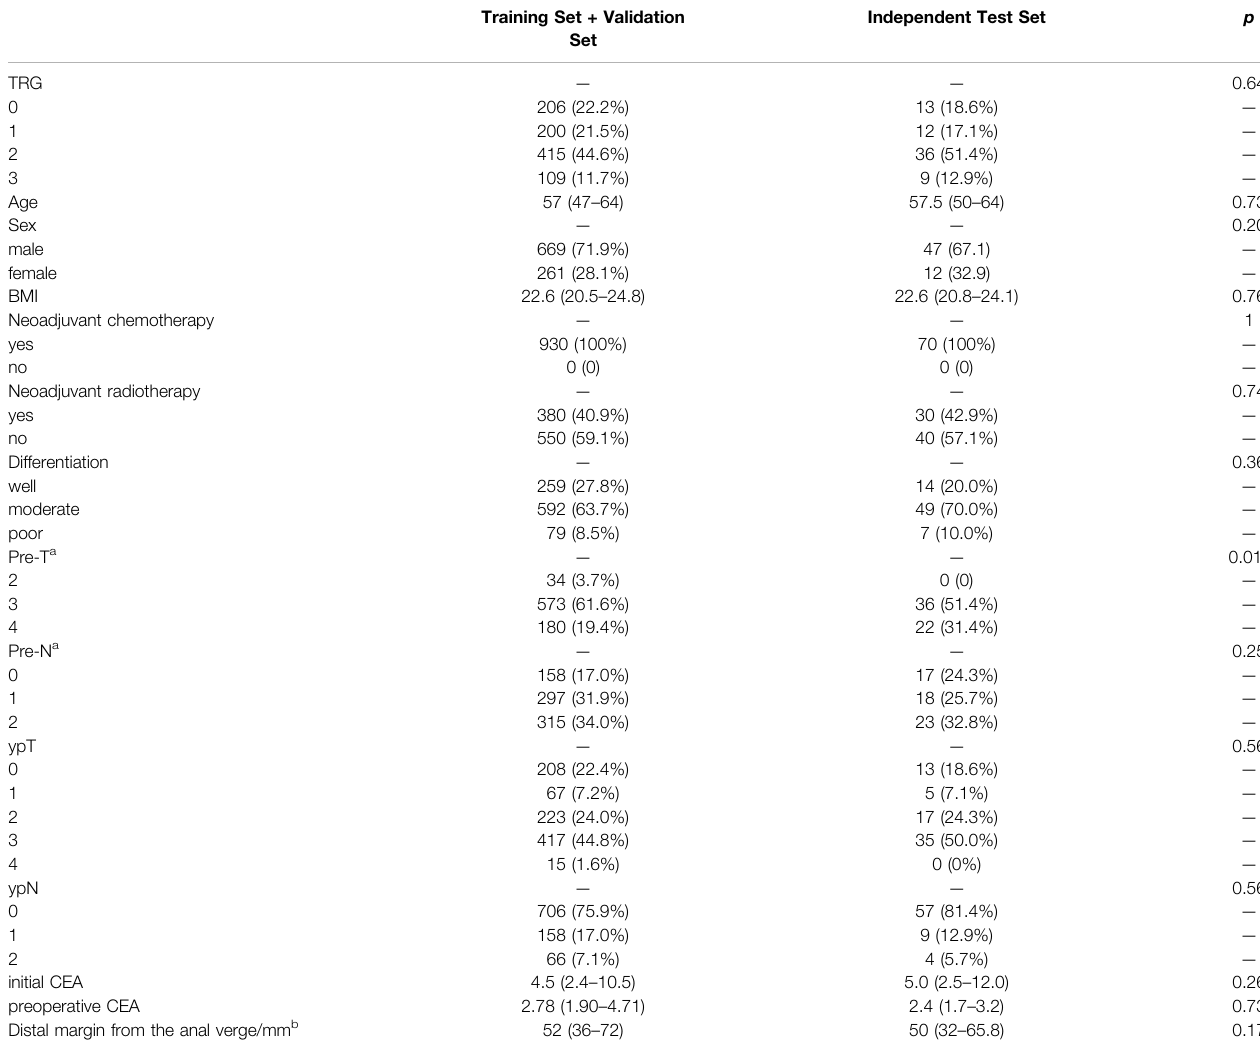
TABLE 1 | Characteristics of locally advanced rectal cancer